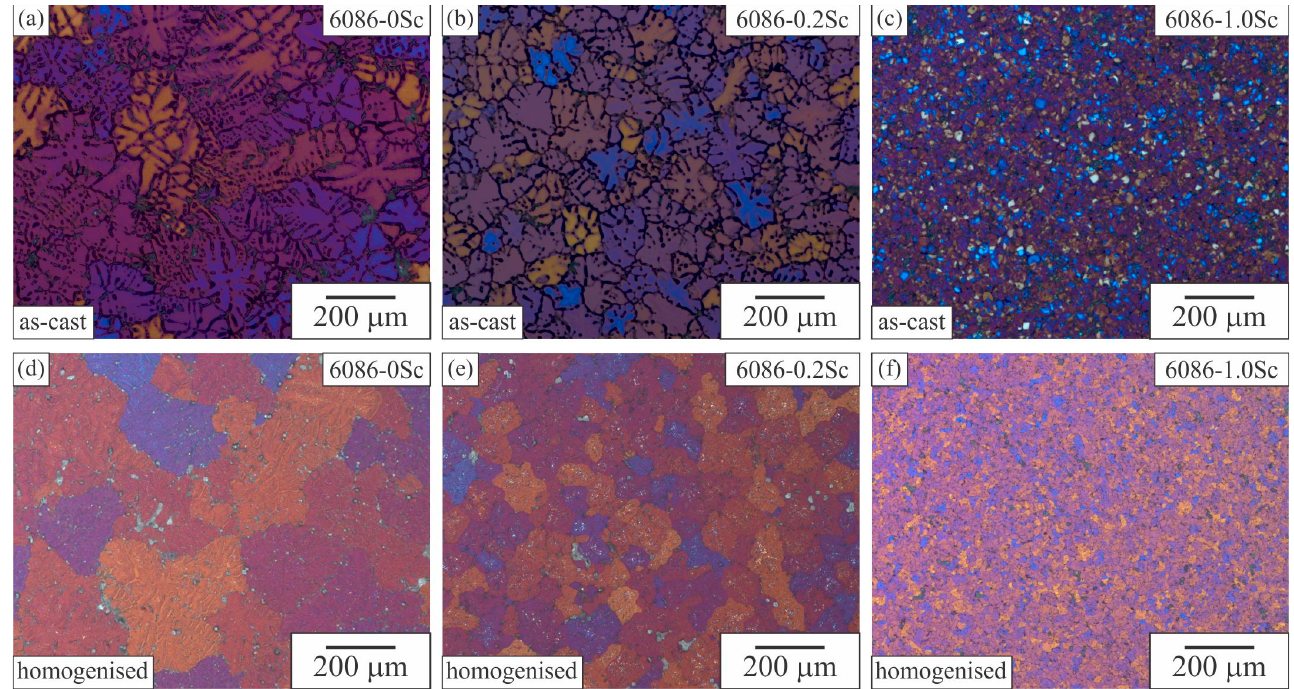
Figure 4. Grain structure of the investigated alloys (light micrographs): ( a – c ) in the as-cast condition, ( d – f ) after homogenisation (520 °C, 40 h). Table 2. Grain sizes in the as-cast condition of the investigated alloys according to ASTM E112.